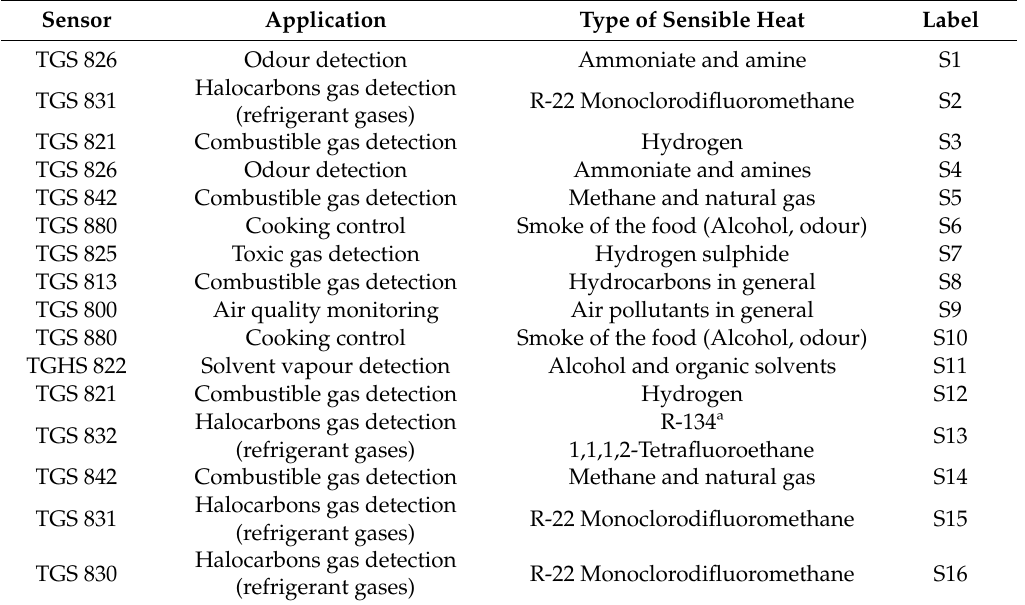
Table 2. List of sensors that make up the sensor matrix of the e-nose.